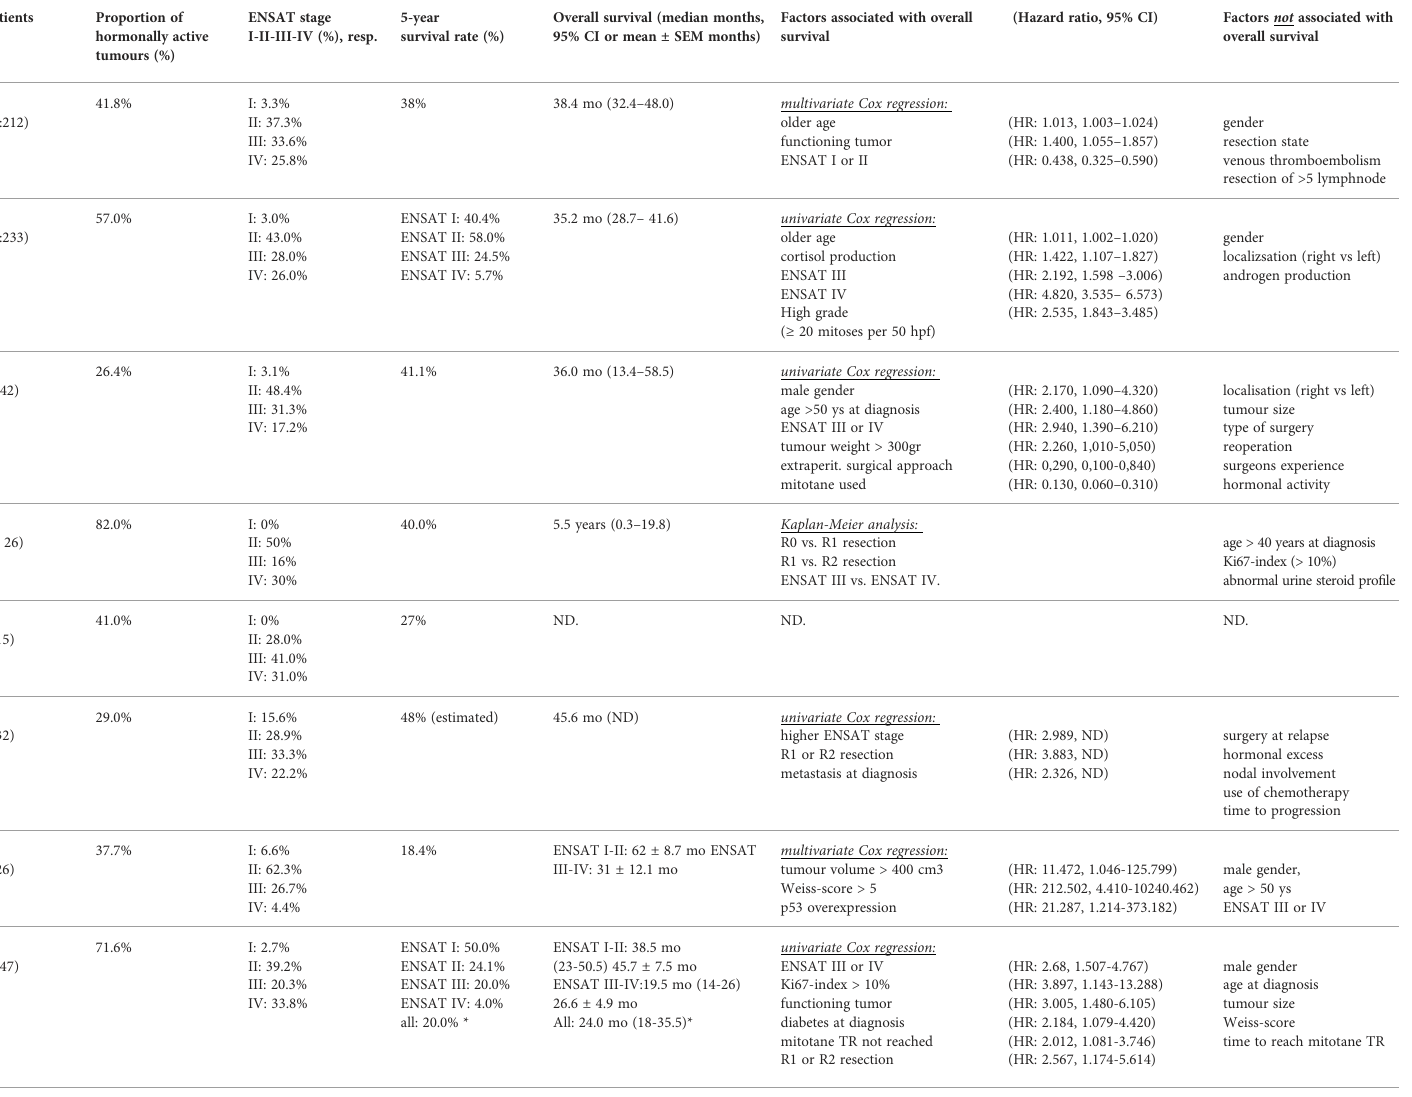
TABLE 5 Prognostic factors and survival in single-centre series with adrenocortical carcinoma. Author (year)